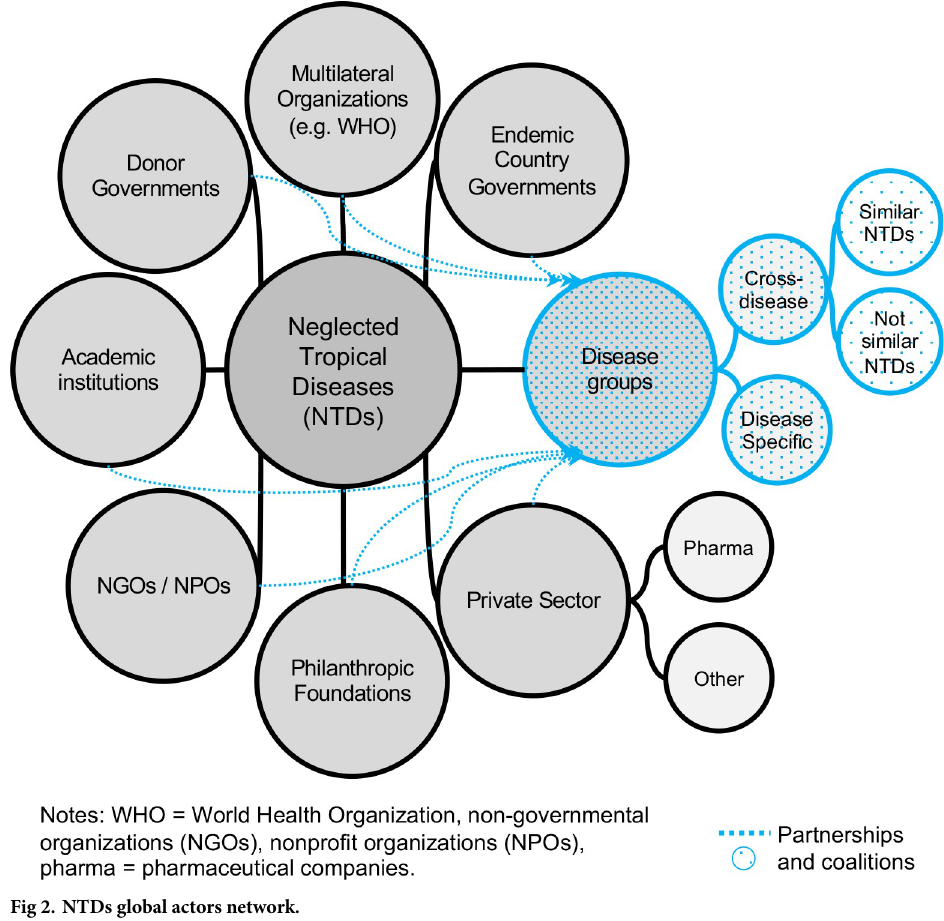
Fig 2. NTDs global actors